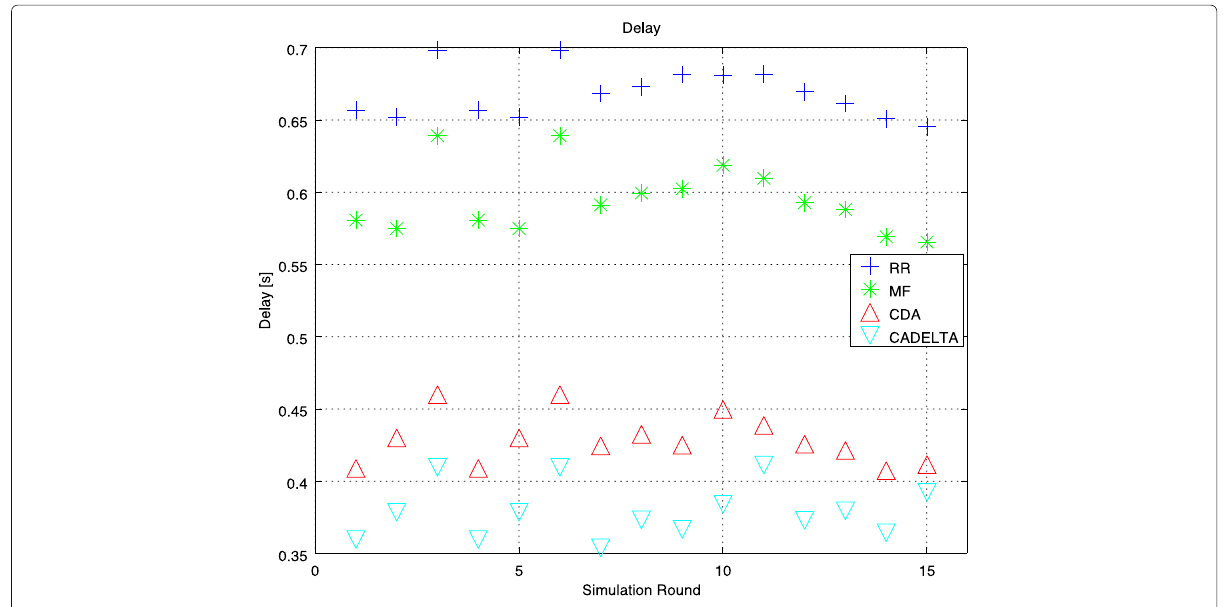
Fig. 10 Delay–video surveillance LQ and video surveillance